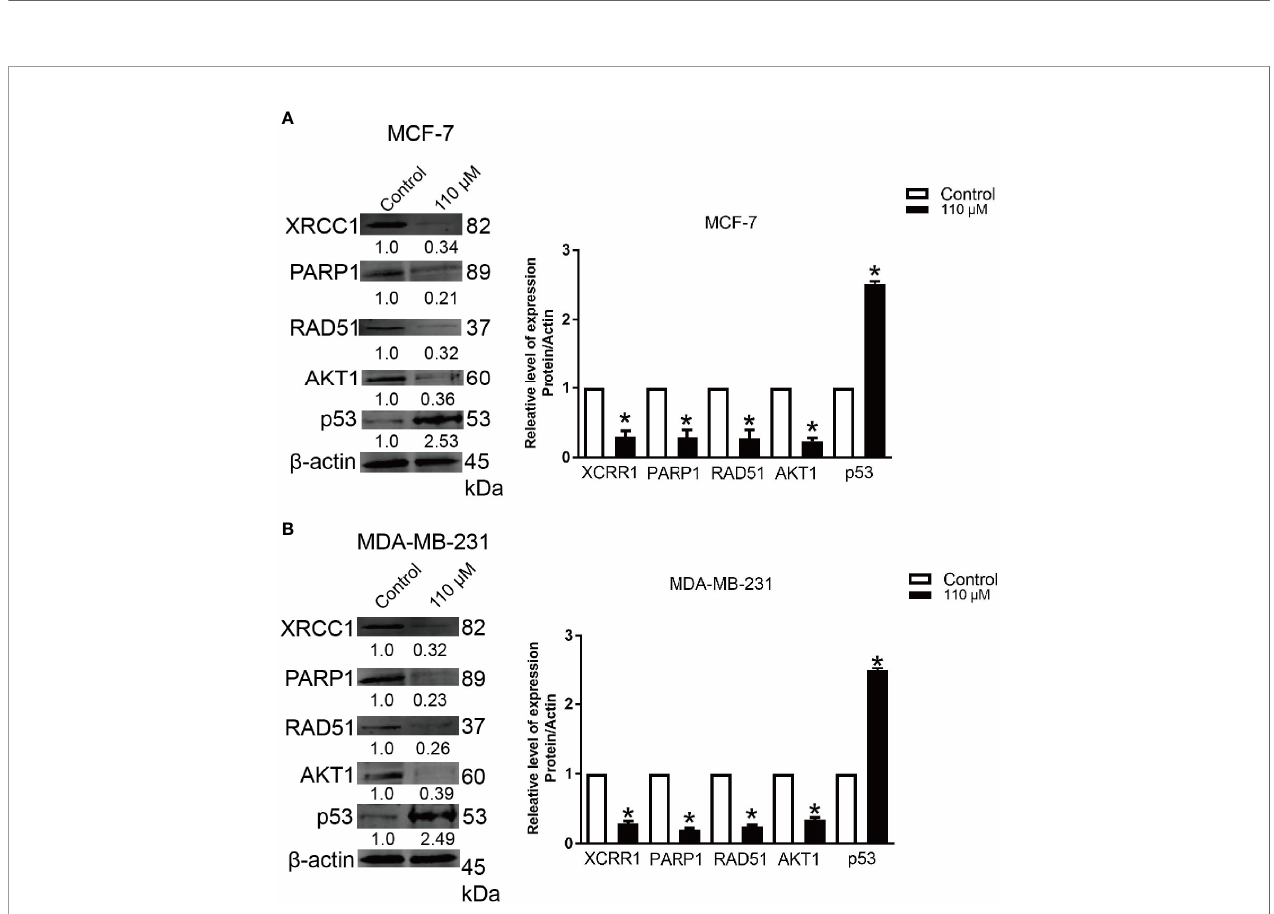
FIGURE 6 | Emodin down-regulates the expression of AKT1, XRCC1, PARP1, and RAD51. BC cells were treated with Emodin (110 m M), for 48 h. The western blotting data shows that Emodin down-regulates the protein levels of AKT1, XRCC1, p53, PARP1, and RAD51. (A) MCF-7 and (B) MDA-MB-231. *p < 0.05 vs the control group. The analysis was conducted using the Student ’ s